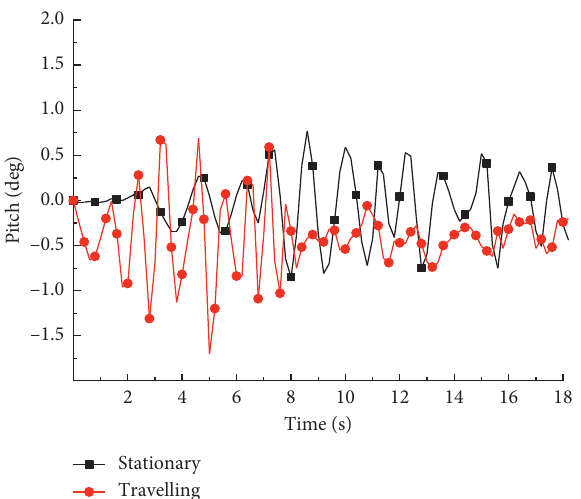
Figure 9: Time history curve of ship pitch in straight section.